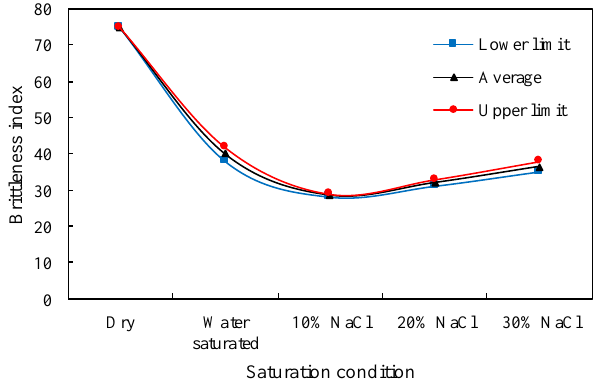
Figure 5. Variation of siltstone BI with pore fluid saturation condition. Note that the BI variation with increasing NaCl concentration exhibits a U-shaped trend, in which BI decreases initially, but increases with increasing NaCl concentration.